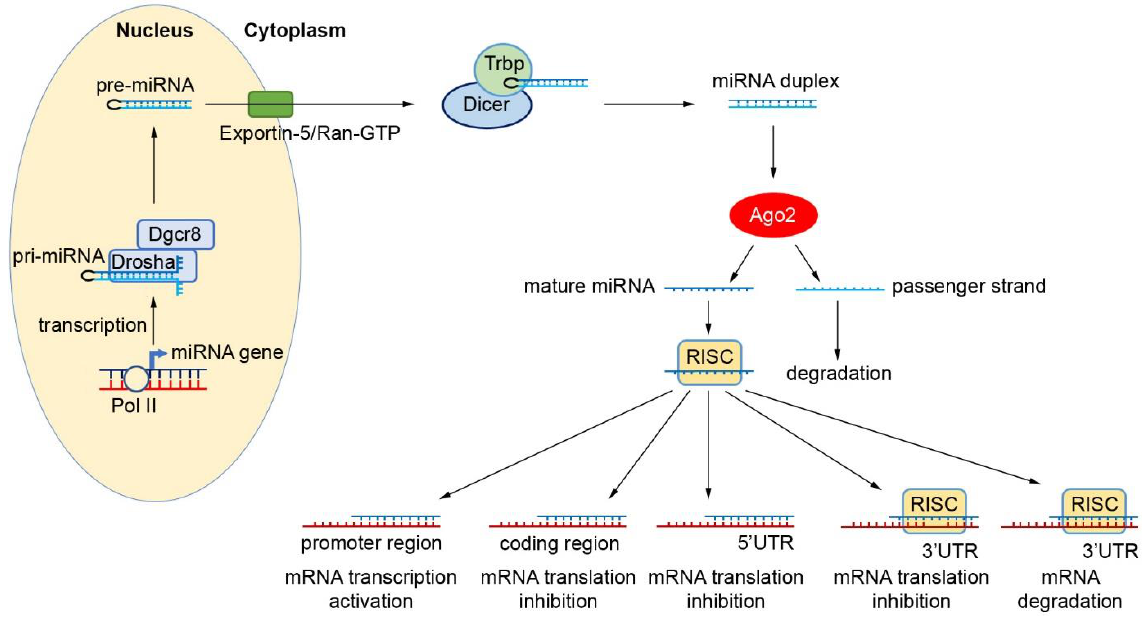
Figure 1. miRNA biogenesis and role in gene regulation. In the nucleus, primary miRNA (Pri-miRNA) is transcribed by RNA polymerase II (pol II). Pri-miRNA is cleaved by Drosha complexed with the protein ‘DiGeorge syndrome critical region 8′ (DGCR 8). Precursor miRNA (pre-miRNA) is released and transported to the cytoplasm by Exportin-5/Ran-GTP, a nuclear export factor. Here, a mature 17–25 bp miRNA duplex is generated through a series of cuts by RNase III endonuclease, Dicer/TRBP and Ago2. This miRNA duplex associates with the RNA silencing complex (RISC) to suppress target mRNAs by binding to the 3′ untranslated region (3′UTR) region. Binding to 5′UTR, 3′UTR and coding region could either inhibit the translation or degrade the mRNAs. Binding to the promoter region could activate the transcription.